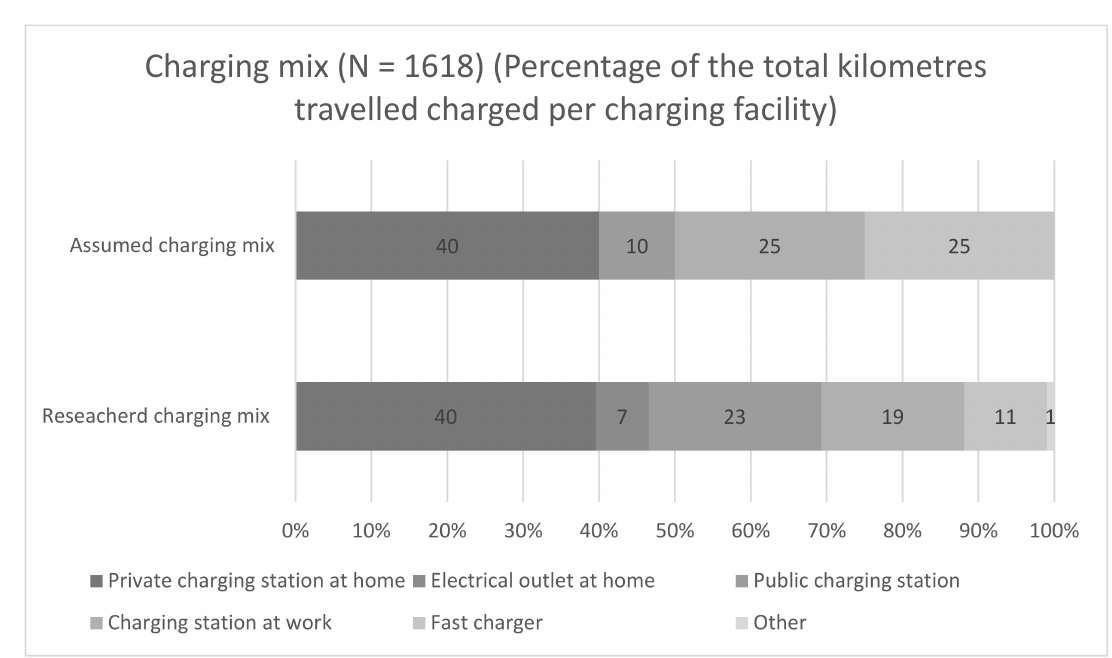
Figure 2. Charging